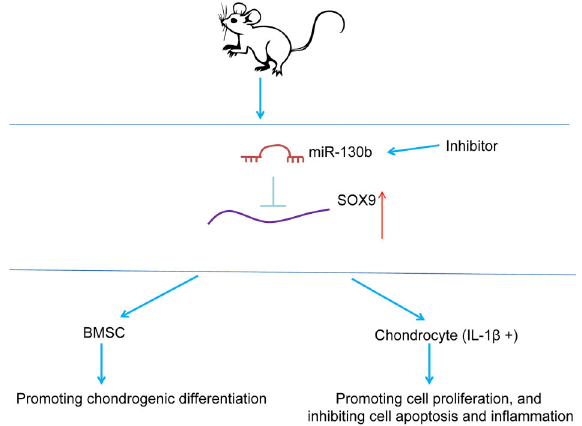
Figure 6. Experimental mechanism diagram. The inhibition of miR-130b promotes the chondrogenic differentiation of bone marrow mesenchymal stem cells (BMSCs) and chondrocyte growth by targeting